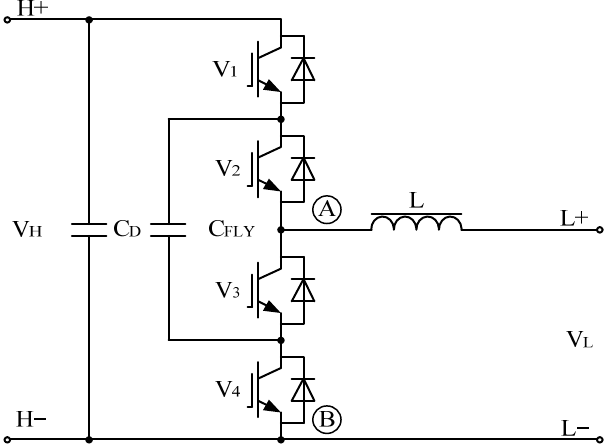
Figure 1. The topological structure of FC ‐ 3L ‐ BDC.